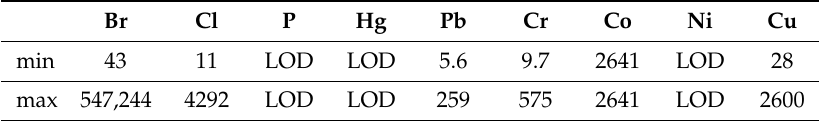
Table 2. Minimum/maximum summary for data in Table